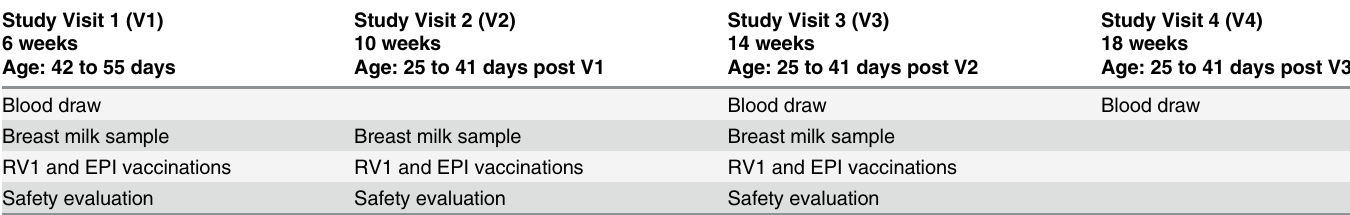
Table 1. Vaccination and Specimen Collection Schedule for both Group 1 and Group 2. Study Visit 1